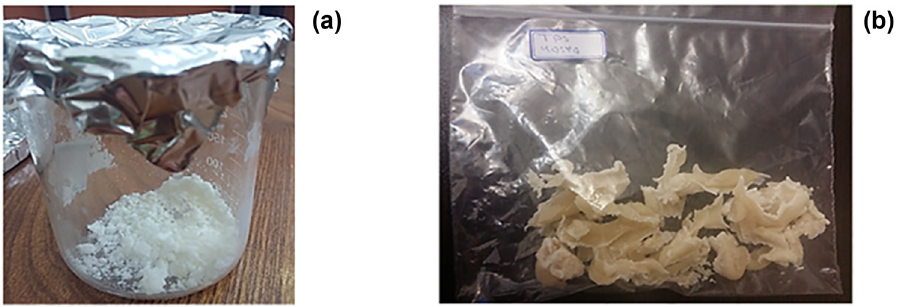
Figure 2: Mixture of starch and glycerol ( a ) and thermoplastic starch ( b ) .